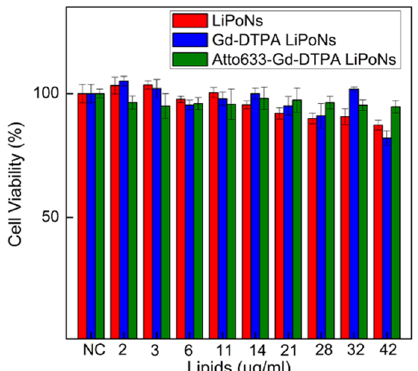
Figure 6. In vitro citotoxicity. Cell viability % of U87 MG cells exposed to an increasing concentra- tion of LiPoNs, Gd-DTPA-loaded LiPoNs and Atto 633-Gd-DTPA co-loaded LiPoNs (Lipid conc.: 2–42 µ g/mL, chitosan conc.: 0.07–2.1 µ g/mL, Gd-DTPA conc.: 3–105 µ M, Atto 633 conc.: 0.01–0.3 µ g/mL) for 24